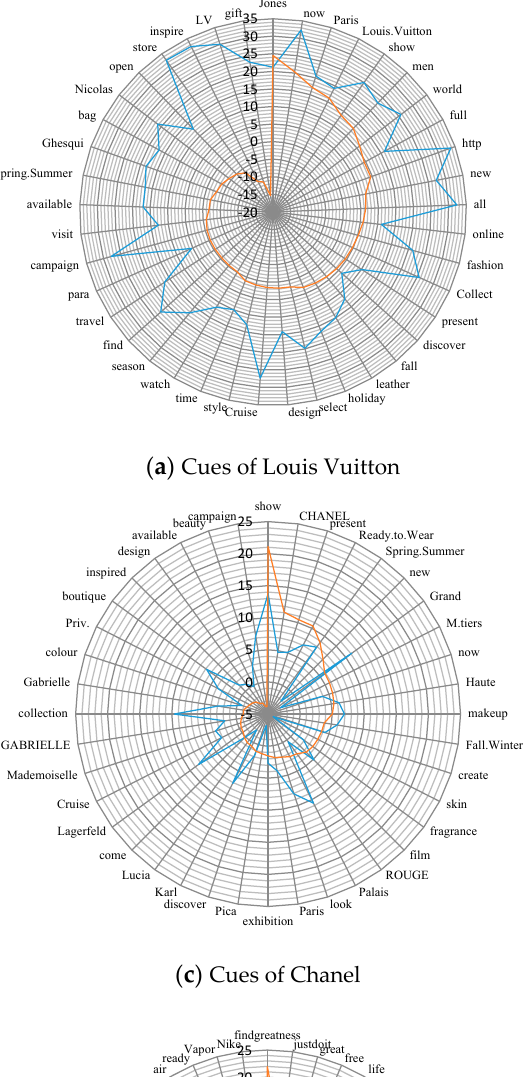
Figure 2. Model results.